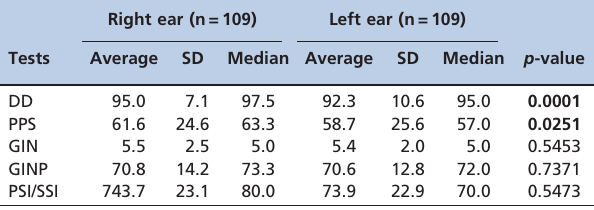
Table 1 - Student performance on the (C)AP tests for the RE and LE.